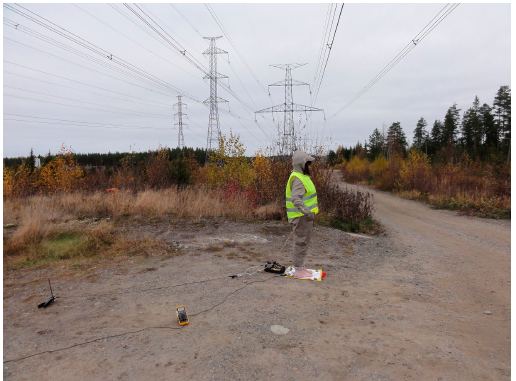
Figure 4. Test subject with grounded arc flash personal protective equipment (PPE).